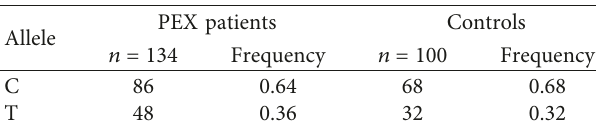
Table 3: Allele frequencies of rs2279590 polymorphisms in Polish population.